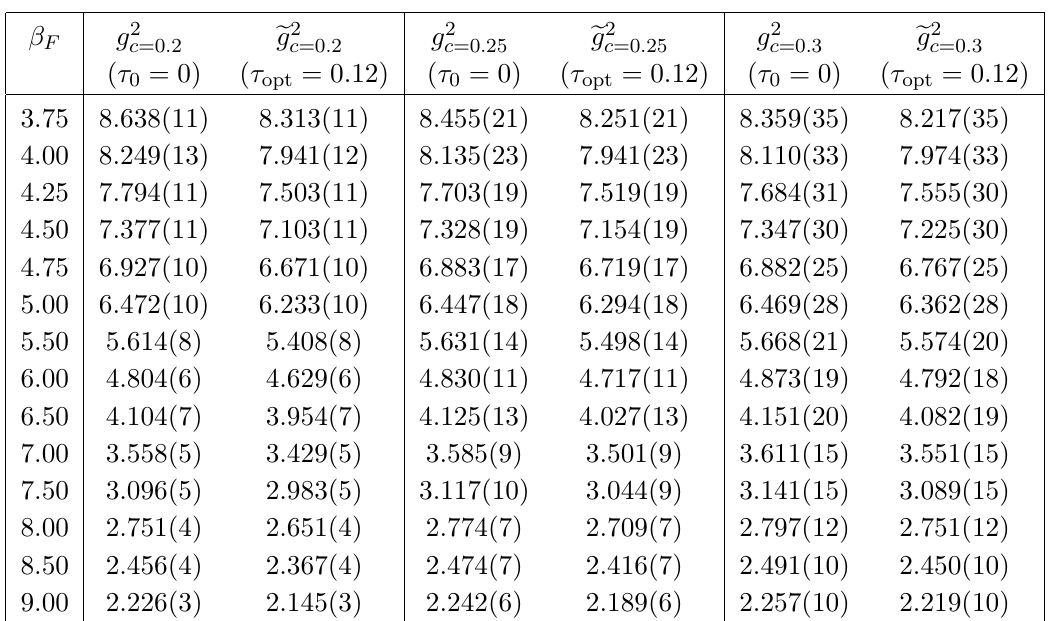
Table 22 . Renormalized gradient (cid:13)ow couplings based on the plaquette discretization of E ( t ) for the 36 4 lattice ensembles used in this work, with columns as in table